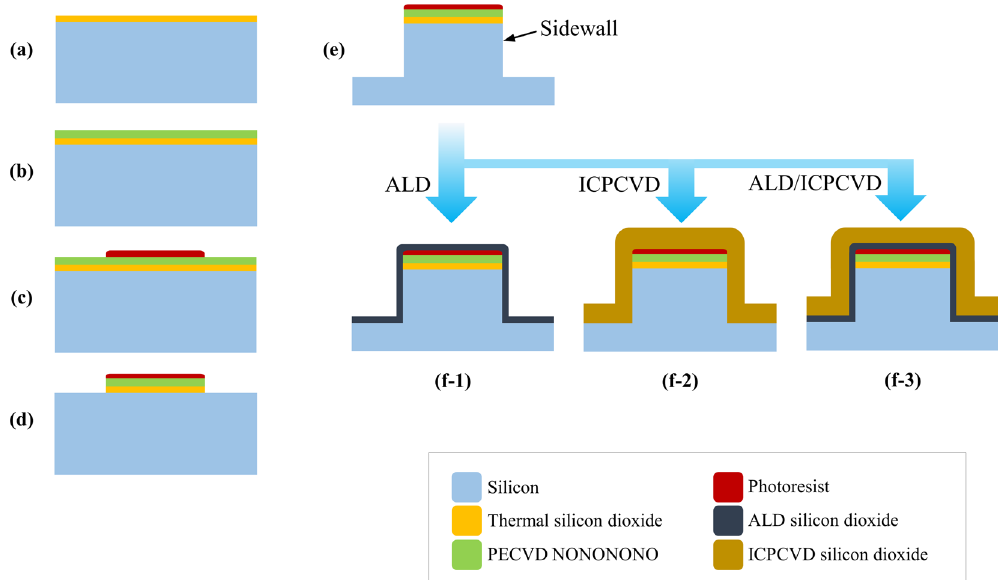
Fig. 5 Fabrication fl owchart showing the device ’ s cross-sectional views. a The starting wafer had a 1 µm-thick layer of thermal SiO 2 over a 500 µm-thick silicon wafer. b SiO 2 / SiN x stack passivation layers were deposited by PECVD. Conductive traces were skipped for simplicity. c The shape of the devices was de fi ned by photolithography. d Reactive ion etching selectively removed SiO 2 and SiN x layers. e Deep reactive ion etching of silicon shaped probe shanks, at which point the silicon sidewalls are exposed. f Conformal coating of silicon sidewalls was achieved by ( f - 1 ) ALD, ( f - 2 ) ICPCVD, or ( f - 3 ) ALD and ICPCVD. The photoresist was left in place during deposition in anticipation of functional device fabrication, in which case the photoresist would be needed to protect the electrode sites until the devices are released from the